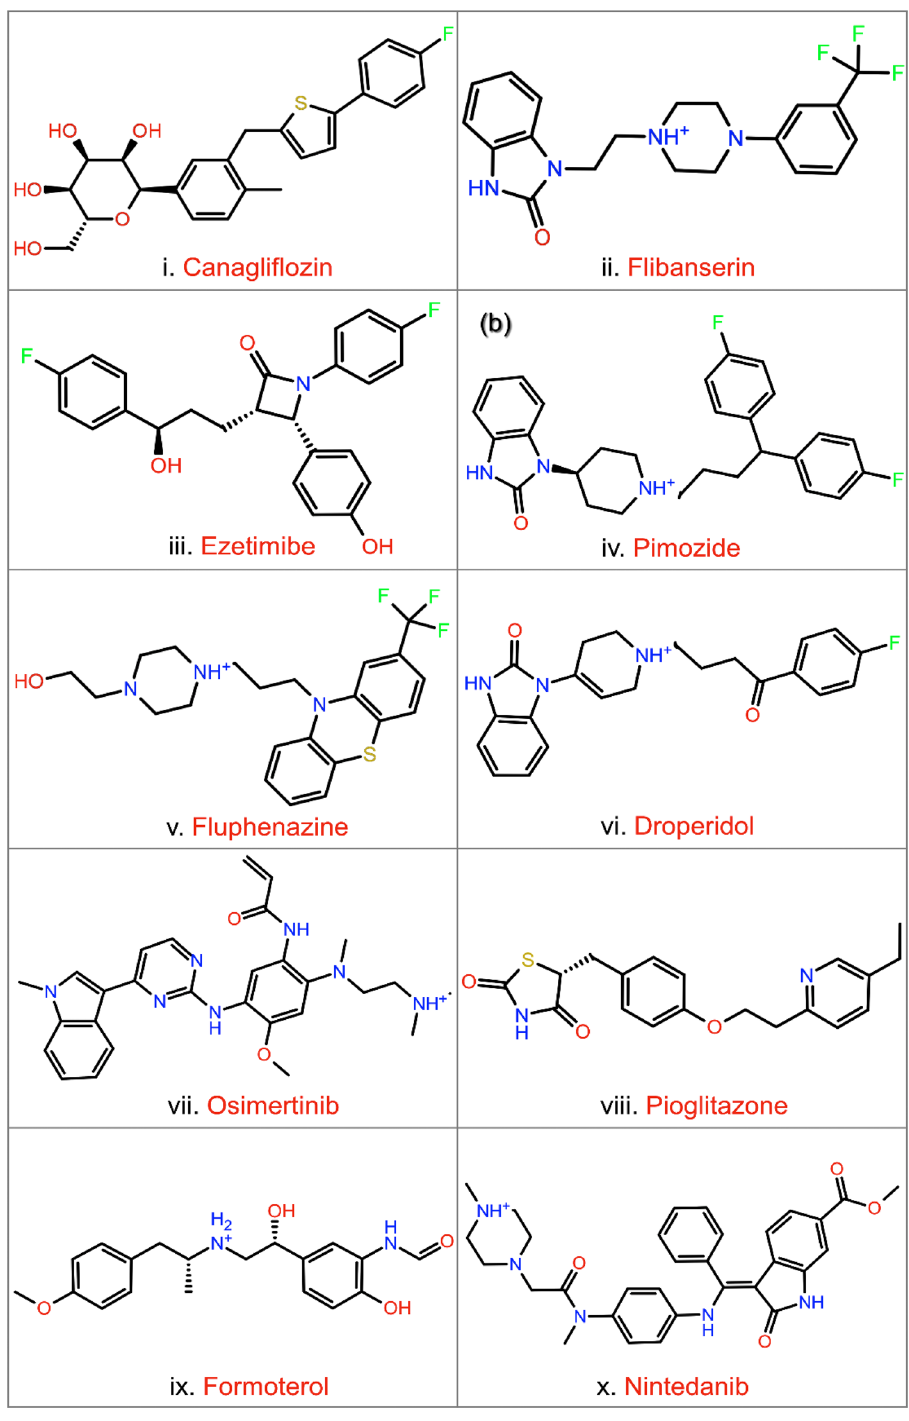
Figure 1. Structural formula and generic names for the potential FDA-approved drugs screened in the selective pocket of Sirt2 using the XP docking method. 2D images were sketched using academic Schrödinger-Maestro v12.4 suite 43 (URL: https:// www. schro dinger. com/ freem